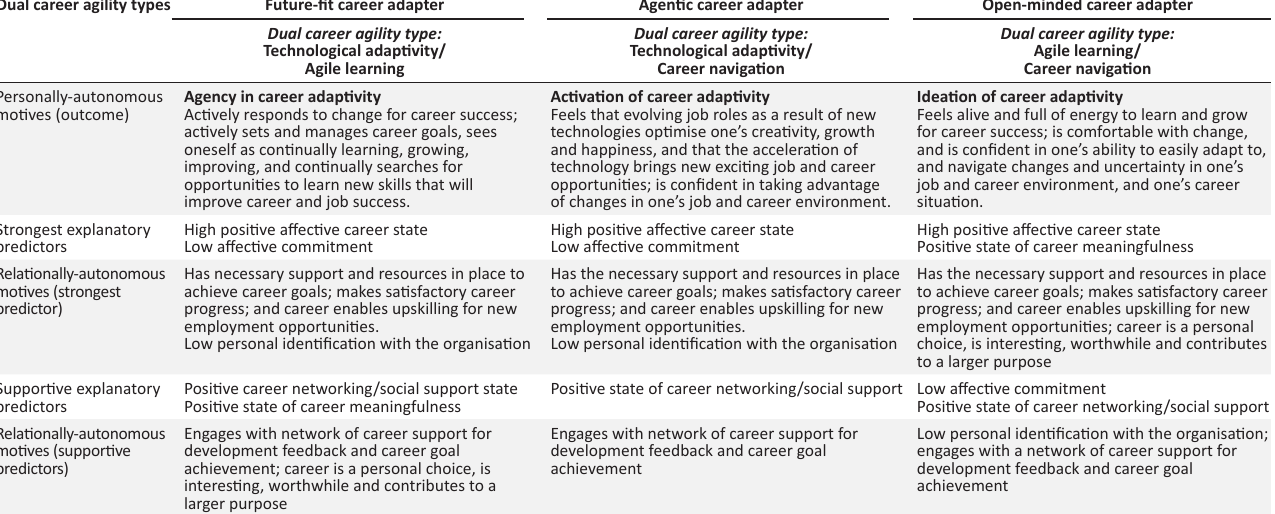
TABLE 4: Dual career agility types and their psychological states of career wellbeing and affective